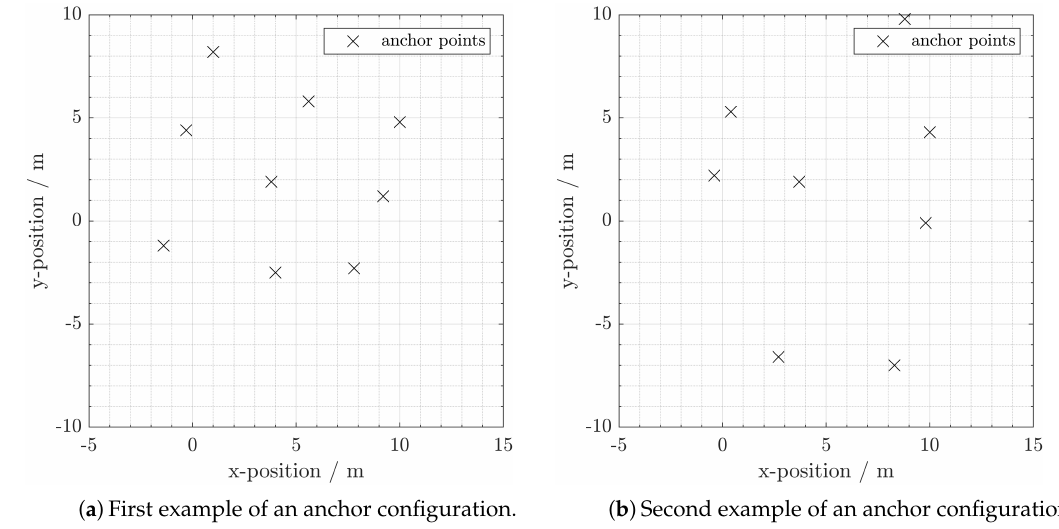
Figure 12. Two examples of the 2000 simulated anchor configurations.